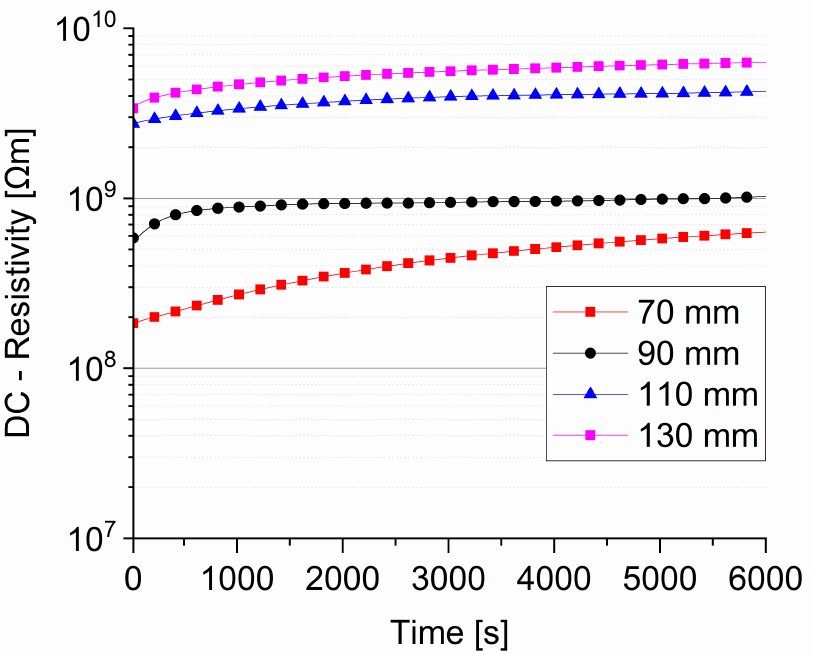
Figure 5. DC resistivity of Al 2 O 3 coatings as a function of time. Table 3. The microstructural parameters (porosity, thickness, main phase) as well as the